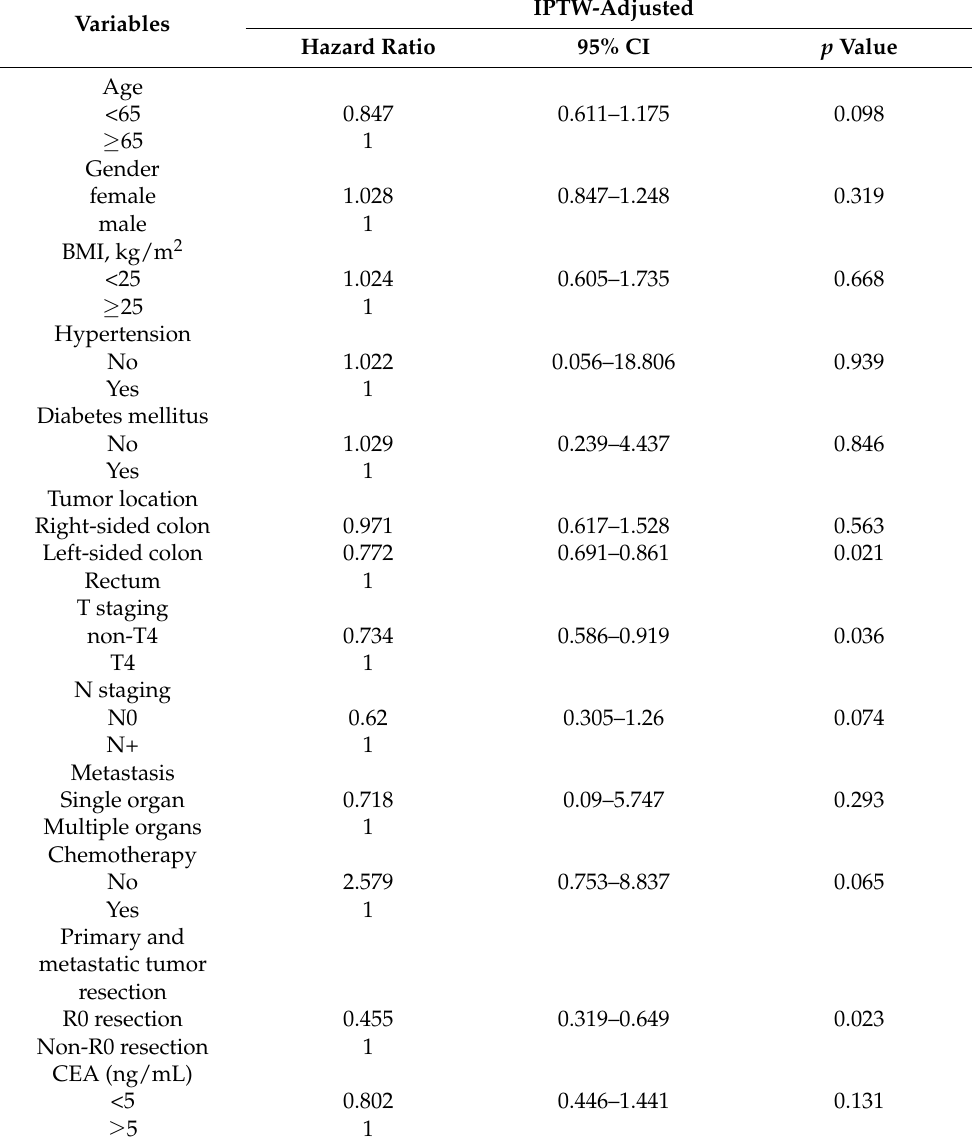
Table 3. Multivariable models from weighted Cox proportional hazard regression for overall